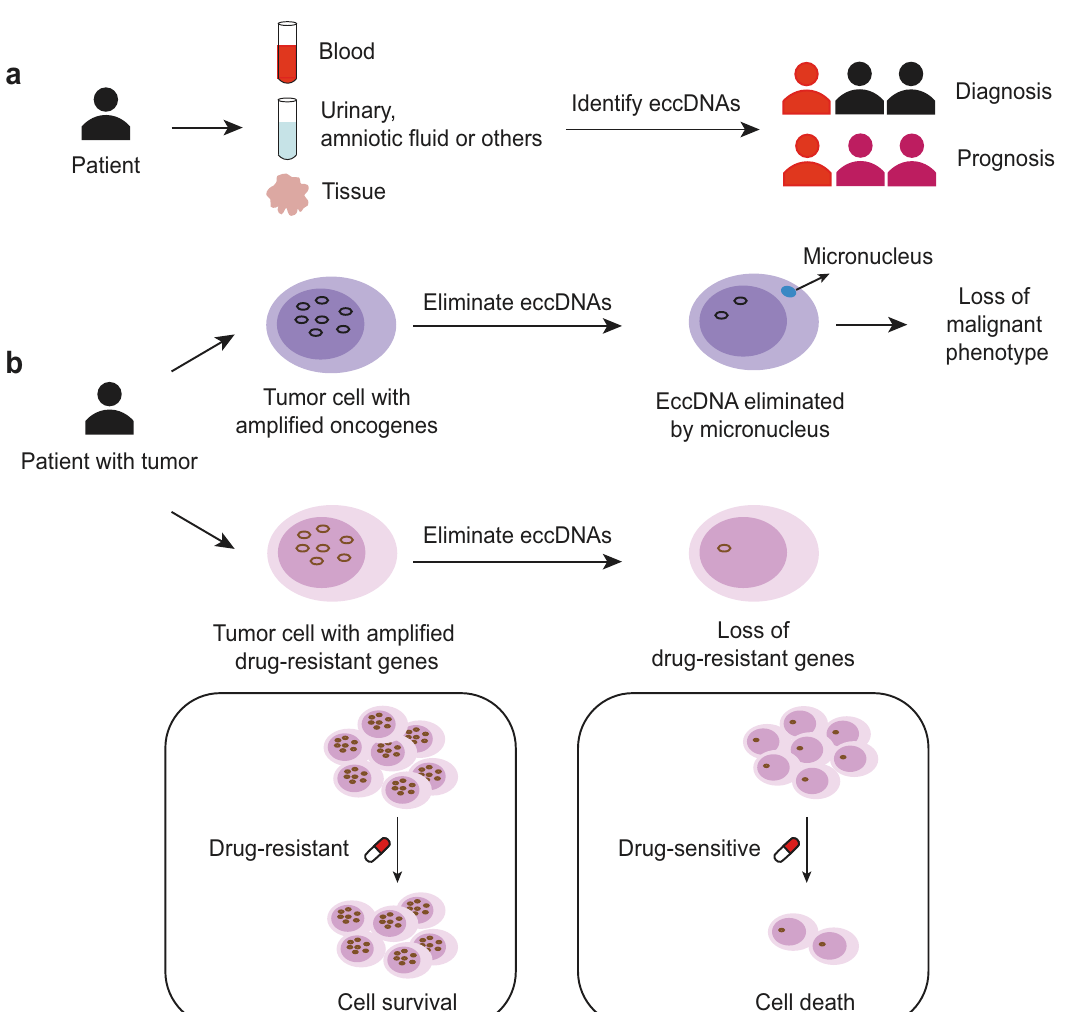
Fig. 8 Clinical applications of eccDNA. The clinical value of eccDNAs in cancer. a EccDNAs can be found in patient samples, such as blood, urine, amniotic fl uid, or tissue. The identi fi cation of eccDNAs would be helpful in cancer diagnosis and prognosis. b Elimination of eccDNA results in a loss of malignant phenotype. It can also lead to a loss of drug-resistance genes and thereby improve therapeutic effects